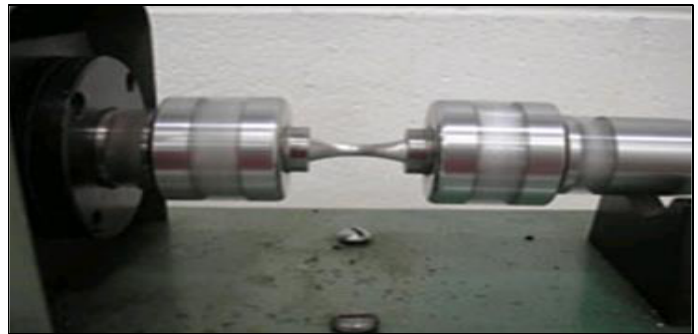
Figure 3. Bench-type rotating – bending fatigue testing apparatus.